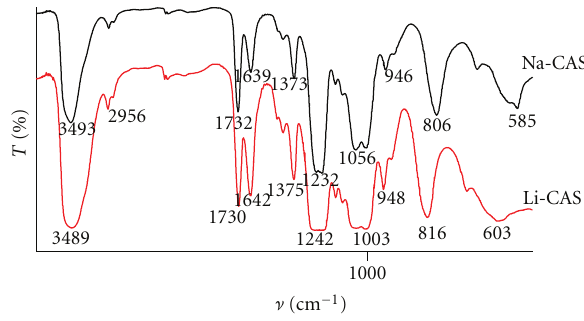
Figure 8: IR spectra of Li- and Na-CAS.